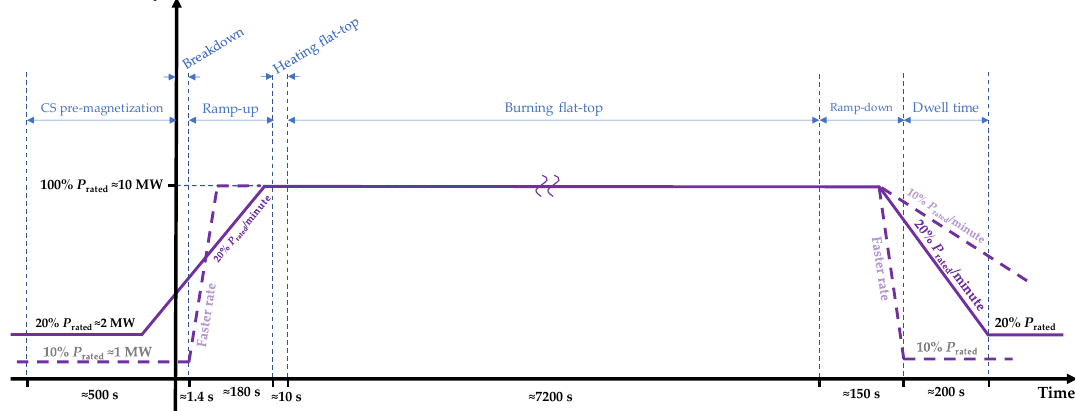
Figure 6. Possible qualitative time evolutions of the power modulation of each of the 18 HCPB OB and IB BB compressors in order to reduce the total power demand. The assumed tradeoff is 20%/minute, a slower rate makes no sense, a faster rate could be detrimental for the components.